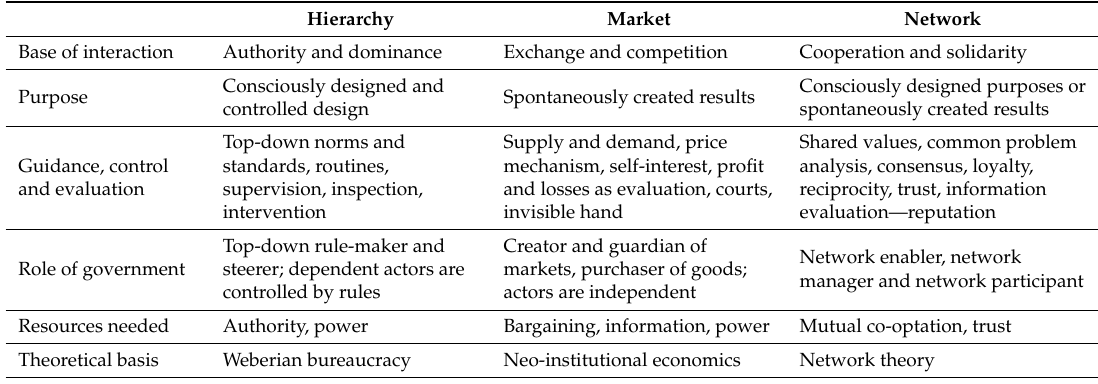
Table 1. The features of hierarchies, markets and